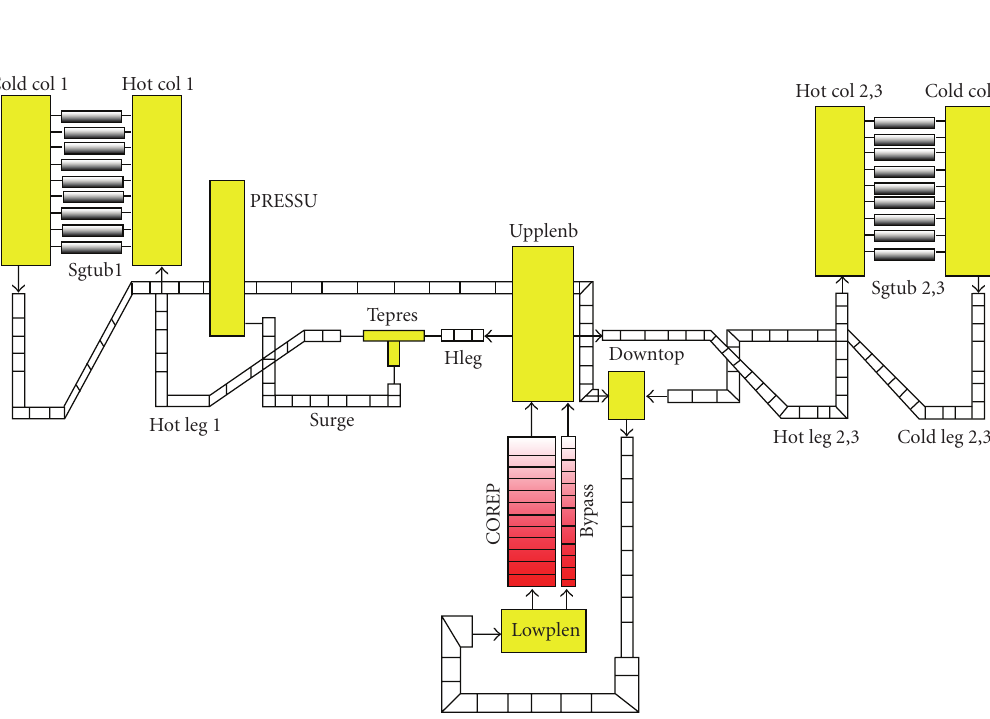
Figure 2: CATHARE core model of PACTEL.